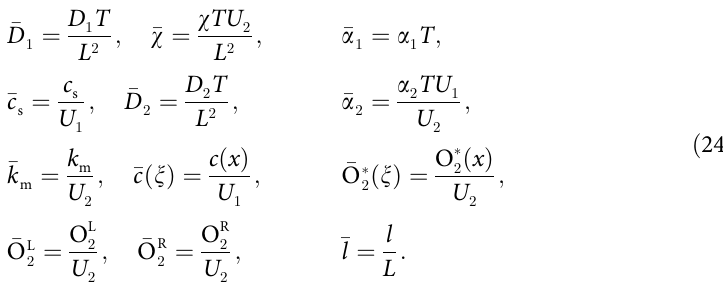
Parameter Value � D 1 � w 1 � a 1 � c s � D 2 � a 2 � k m � l 50 � y 2 D � y 2 � k